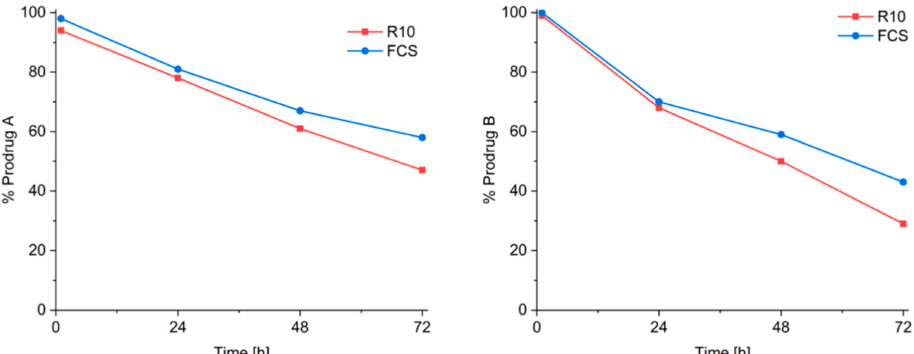
Figure 4. Stability of prodrug A (left) and prodrug B (right) in RPMI-1640 medium containing 10% FCS (R10, red line) and pure fetal calf serum (FCS, blue line) for up to 72 h.